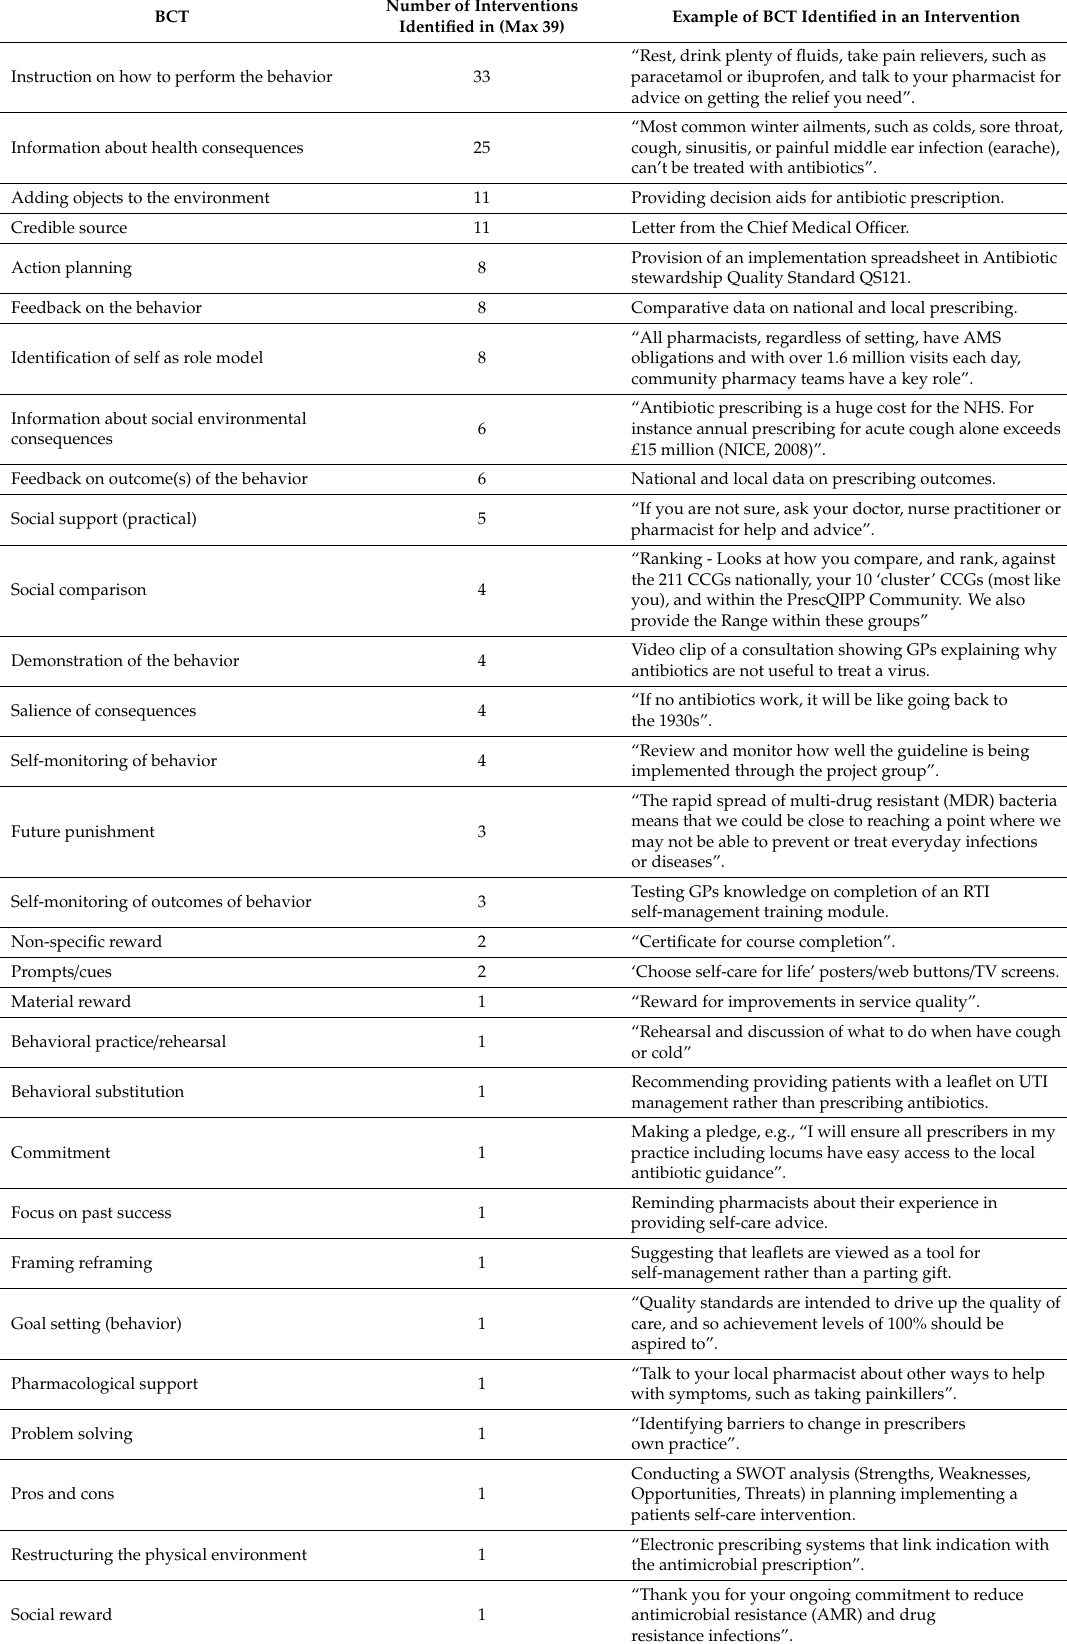
Table 5. Frequency of Behavior Change Techniques (BCTs) in